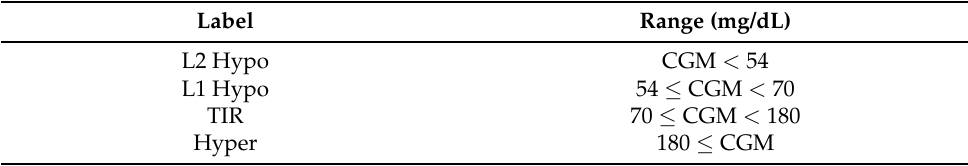
Table 3. Ranges of values where a patient’s blood glucose can be